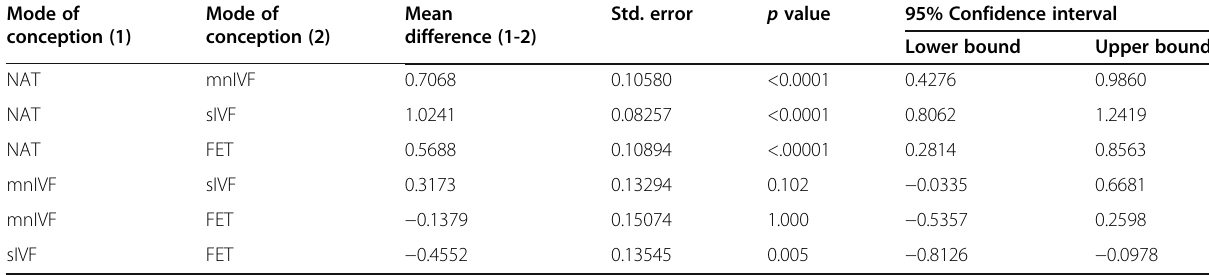
Table 3 Multiple comparisons of gestational age between different modes of conception Mode of conception (1)